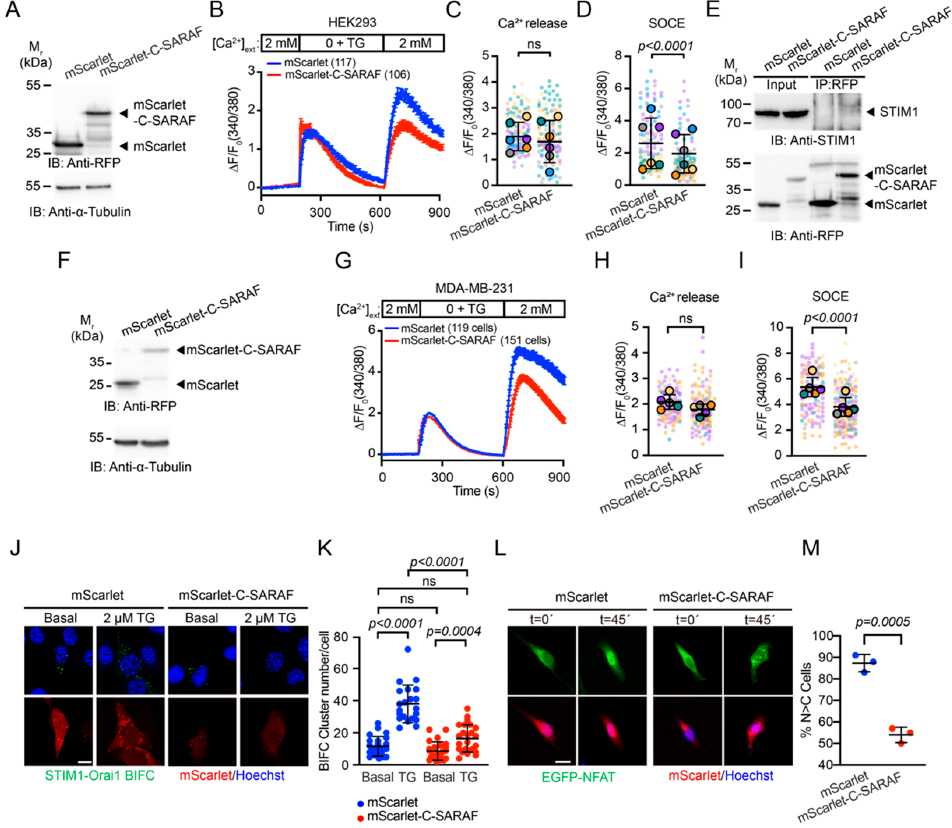
Figure 2. The C-terminal fragment of SARAF reduces SOCE response. ( A ) Representative immunob- lot of mScarlet and mScarlet-C-SARAF overexpression in HEK293 cells. ( B ) Mean traces of SOCE response in HEK293 cells overexpressing mScarlet or mScarlet-C-SARAF. Error bars correspond to standard error. ( C ) Thapsigargin-induced Ca 2+ peak quantification. ( D ) Ca 2+ influx observed in the SOCE response. Small points represent individual cells. Color circles represent average of each in- dependent experiment. Bar represents the average of individual points. Error bars correspond to standard deviation. Mann–Whitney’s non-parametric t-test was applied to define statistical signifi- cance. ( E ) Co-immunoprecipitation of mScarlet and mScarlet-C-SARAF and endogenous STIM1 from HEK293 cells in resting conditions. Immunoblots of input and immunoprecipitation (IP) prod- ucts are shown. Arrowheads indicate STIM1 and mScarlet or mScarlet-C-SARAF bands, respec- tively. A representative immunoblot of three independent experiments is shown. ( F ) Representative immunoblot of mScarlet and mScarlet-C-SARAF overexpression in MDA-MB-231 cells. ( G ) Repre- sentative graph of SOCE response in MDA-MB-231 cells overexpressing mScarlet or mScarlet-C- SARAF. Error bars correspond to standard error. ( H ) Ca 2+ peak quantification induced by reticular Ca 2+ depletion in ( G ). ( I ) Quantification of Ca 2+ influx observed in the SOCE response. Small points represent individual cells. Colored circles represent the average of each independent experiment. Bars represent the average of individual points. Error bars correspond to standard deviation. Statis- tical analyses correspond to Mann–Whitney’s test. ( J ) Representative panel of the effect of mScarlet or mScarlet-C-SARAF overexpression in MDA-MB-231 cells on BiFC STIM1-Orai1 formation. The cells were treated with 2 µM TG for 45 min at 37 °C in Ringer’s solution modified with 2 mM CaCl 2 ( K ) Quantification of fluorescence puncta from BiFC STIM1-Orai1 formation. Bars represent average response. Error bars correspond to standard deviation. Scale bar = 20 µm. Individual points repre- sent the response of each cell. Statistical analyses correspond to ANOVA followed by Dunnett’s multiple comparison test. ( L ) Representative panel of the effect of mScarlet or mScarlet-C-SARAF overexpression in MDA-MB-231 cells on EGFP-NFAT translocation. ( M ) Quantification of the trans- location of NFAT to the nucleus observed in ( L ). Bars represent average response. Error bars corre- spond to standard deviation. Scale bar = 20 µm. Individual points represent the average response of each experiment. Statistical analyses correspond to Welch’s test.